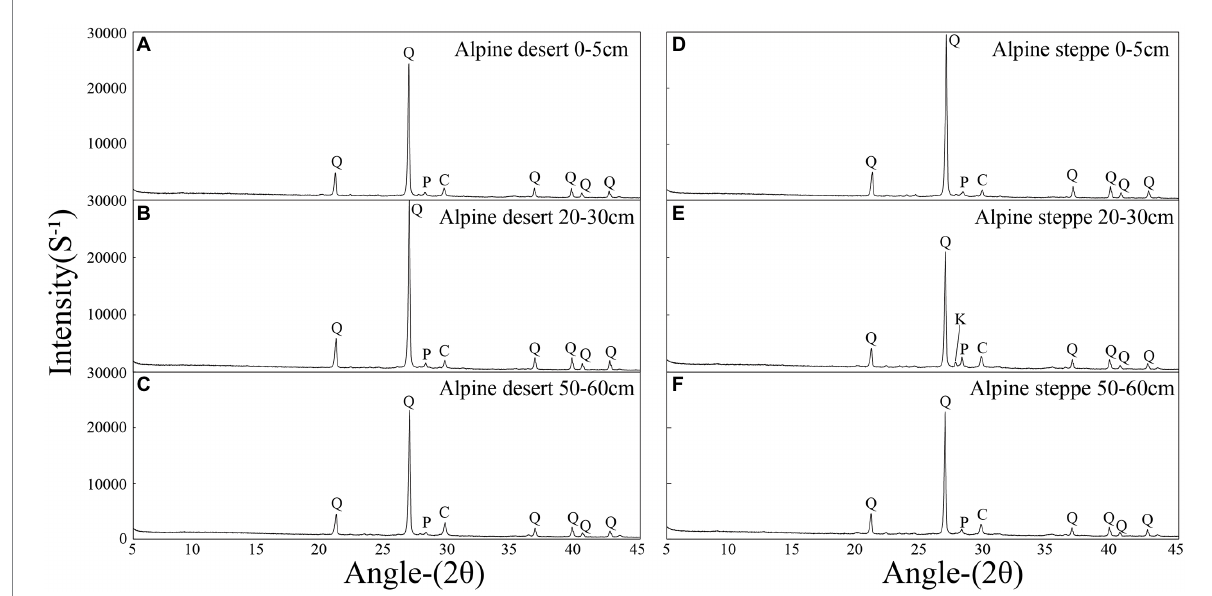
FIGURE 2 X-ray diffraction patterns of the typical samples. The 0–5 cm layer of the alpine desert (A) ; the 20–30 cm layer of the alpine desert (B) ; the 50– 60 cm layer of the alpine desert (C) ; the 0–5 cm layer of alpine steppe (D) ; the 20–30 cm layer of the alpine steppe (E) ; and the 50–60 cm layer of the alpine steppe (F) . Abbreviations for various minerals: Q-, quartz; C-, calcite; P-, plagioclase; K-, potassium feldspar.